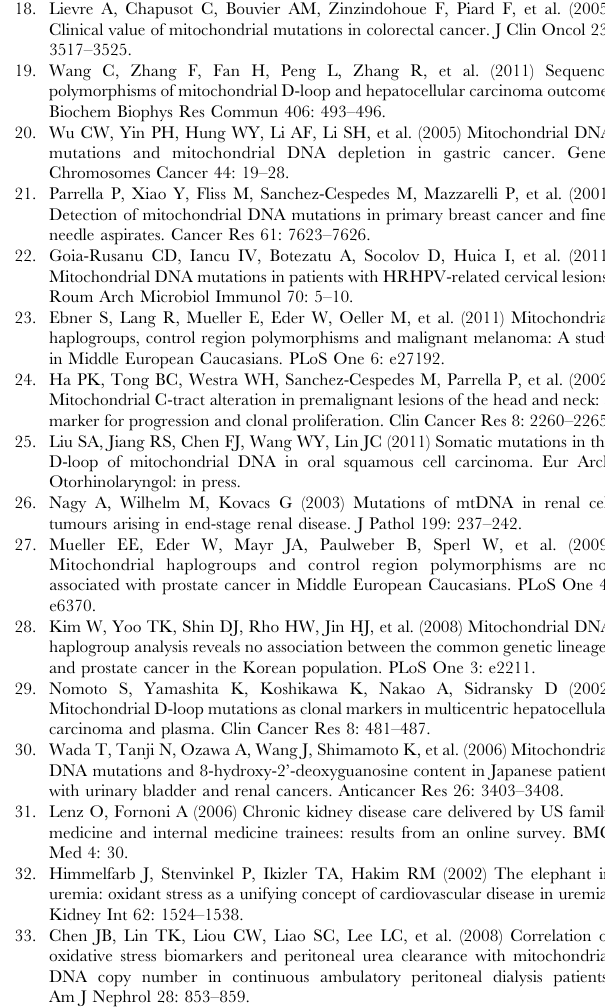
Table S1 Case (n= 193)-D-loop trimmed sequences in FSATA format.